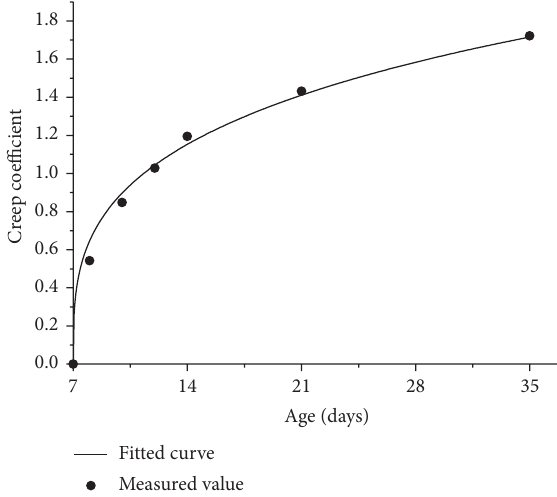
Figure 6: Measured creep coefficients and analyzing